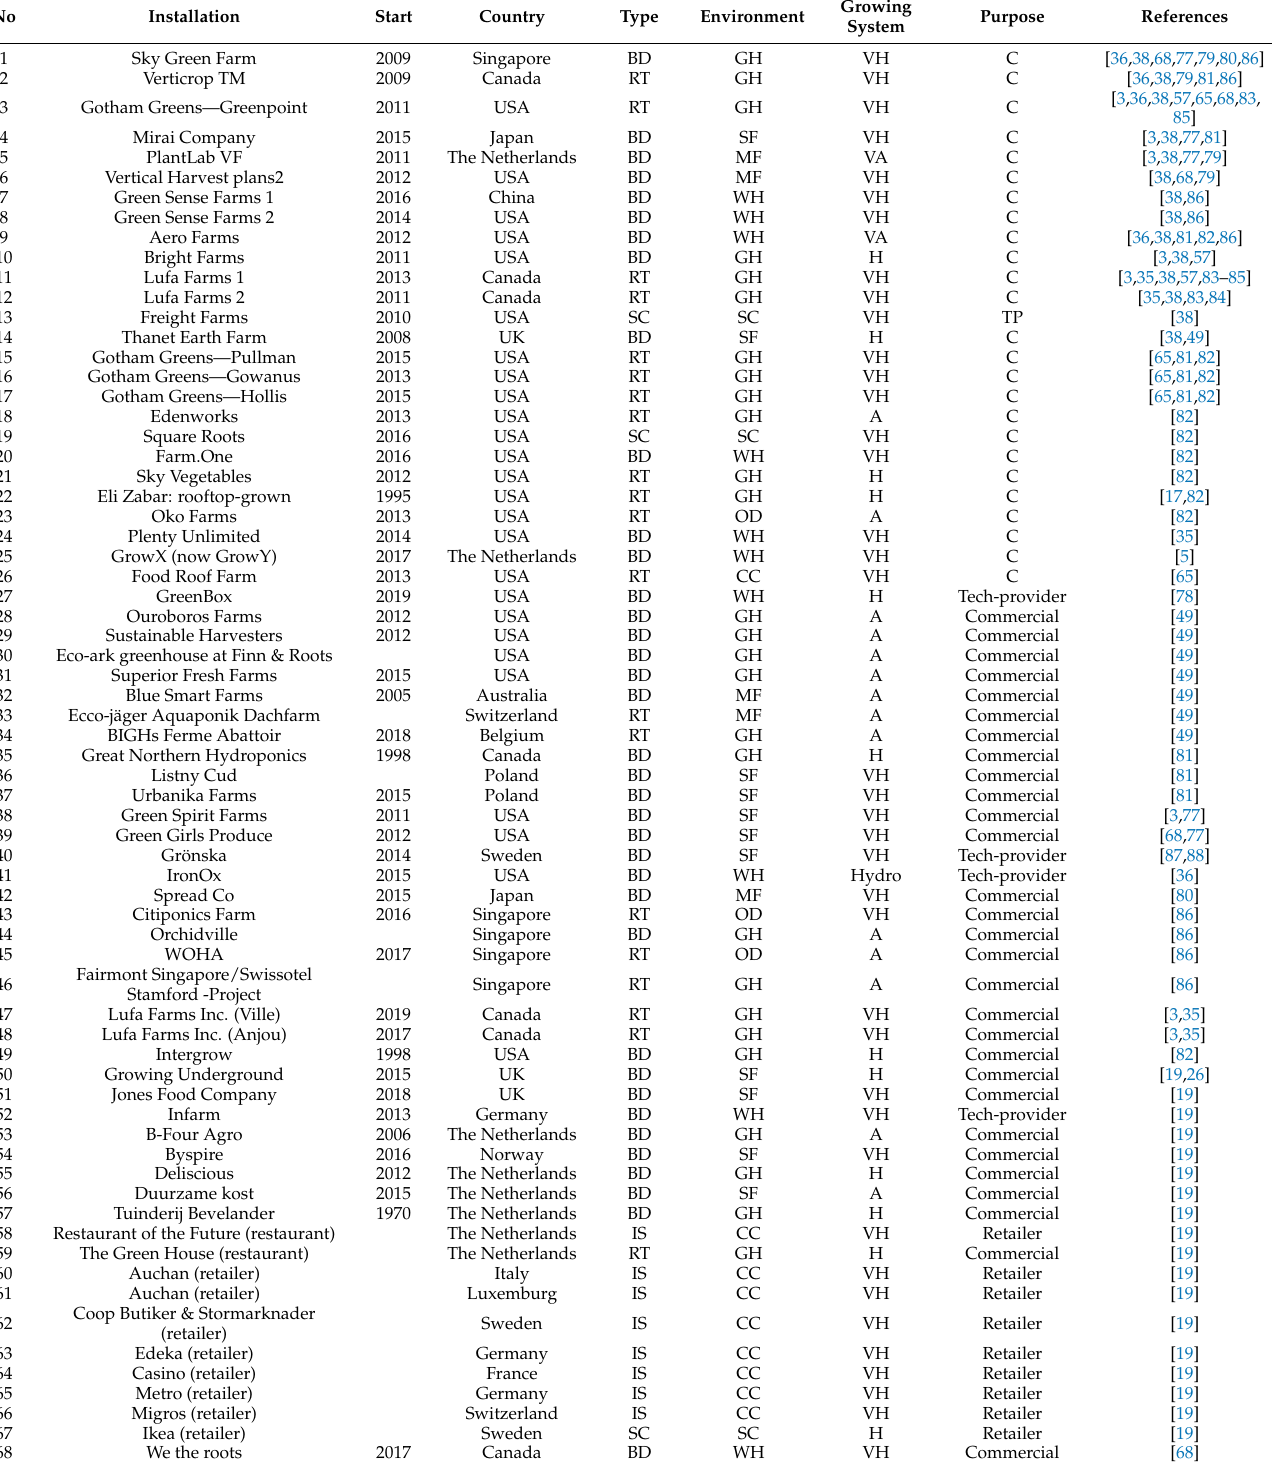
Table 1. Active UA installations with CEA by country, start year, the ‘type’ of location of technology (BD: inside built structure, RT: on building rooftop, SC: inside a shipping container near buildings, IS: Instore of retailers), built urban environment (MF: across multiple floors, SF: installed in a single floor, WH: a specific warehouse, CC: a climate chamber, OD: outdoor on rooftops), growing